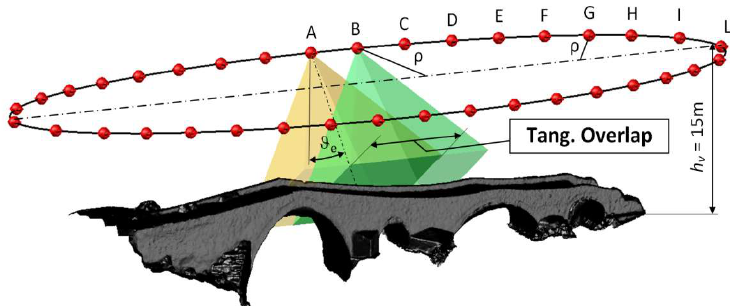
Figure 6. Waypoint and overlap in EG at h v = 15 m.